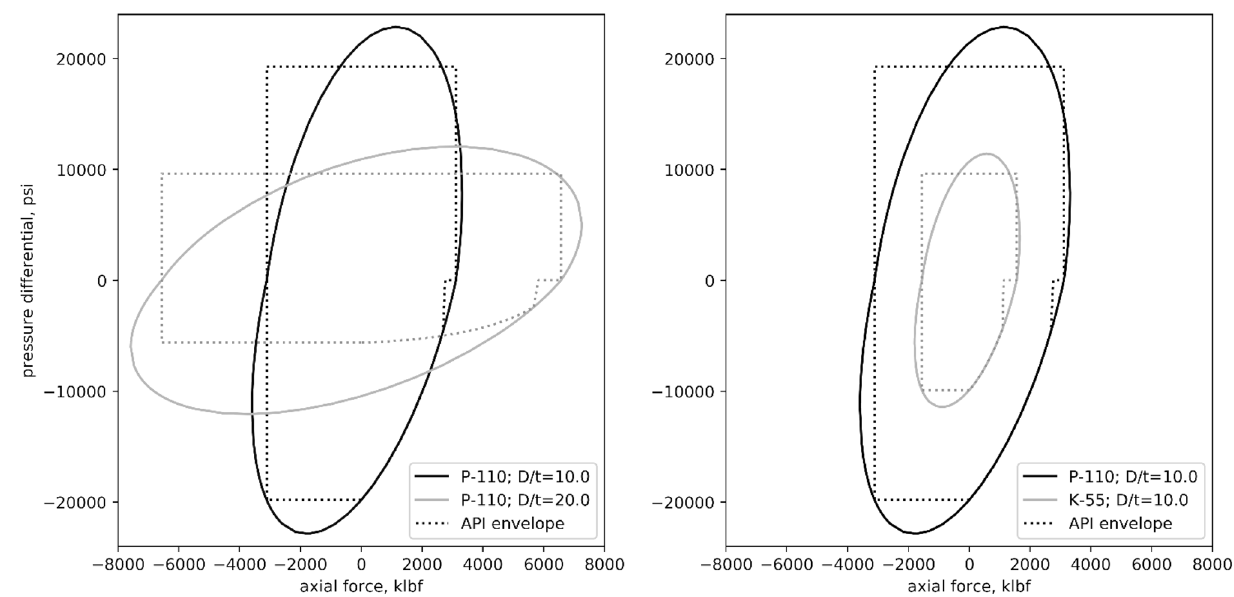
Fig. 3 von Mises ellipse and API envelope for some tube configurations, varying D ∕ t and Y p